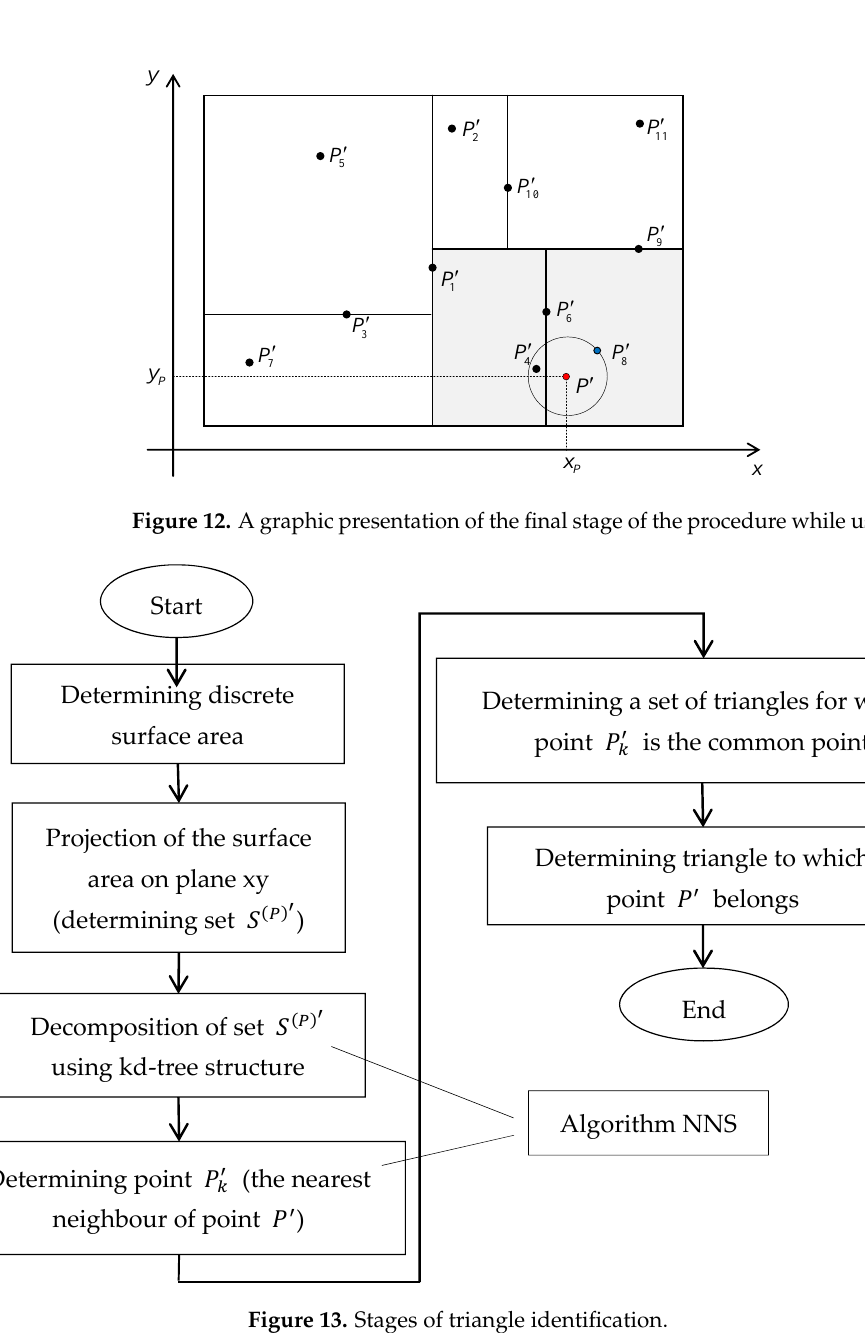
Figure 13. Stages of triangle identification.